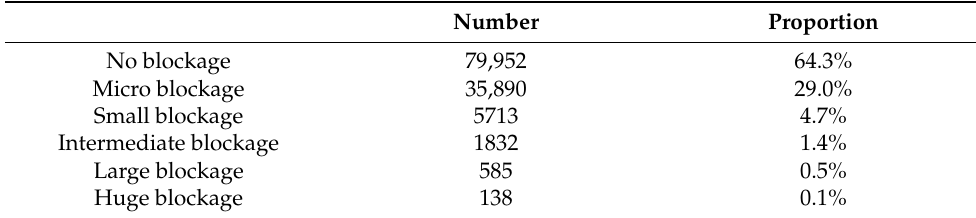
Table 2. Data distribution and proportion in the original dataset.